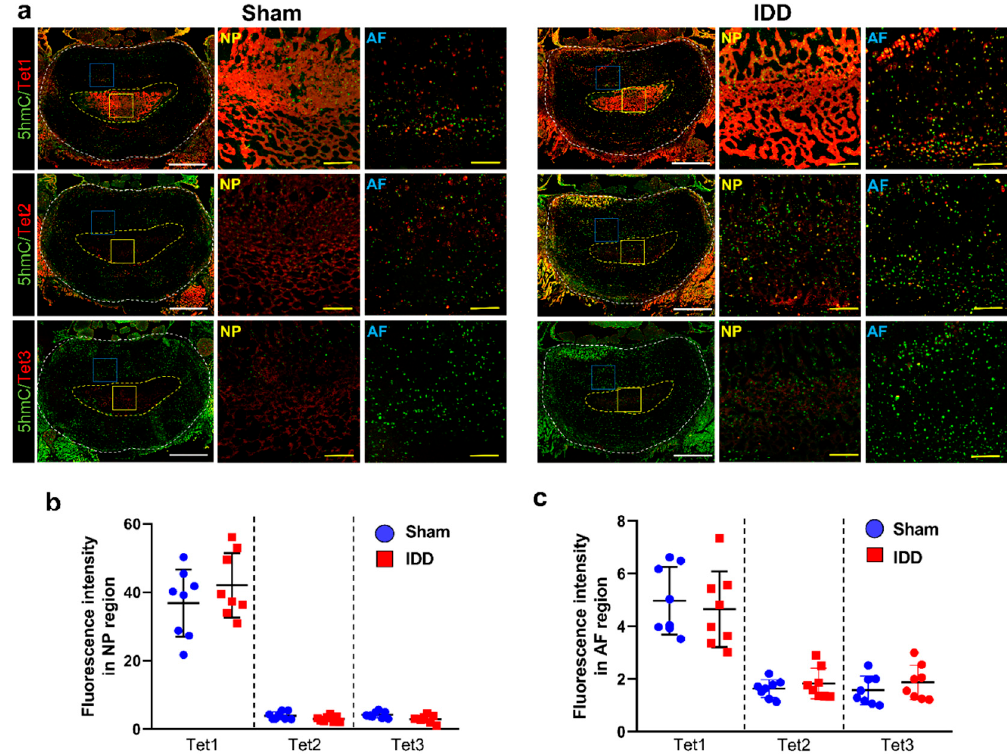
Figure 7. ( a ) Representative immunohistochemical low and high images for 5hmC (green) and Tet1, Tet2, or Tet3 (red) in the NP and AF regions of the sham and IDD groups White scale bar = 1000 µm, Yellow scale bar = 100 µm; ( b , c ) Relative intensity of Tet1, Tet2, or Tet3 expression in the NP and AF regions of the sham and IDD groups ( n = 8/group). Data are expressed as the mean ± SEM. 5hmC, 5-hydroxymethylcytosine; AF, annulus fibrosus; IDD, intervertebral disc degeneration; NP, nucleus pulposus; SEM, standard error of the mean; Tet, Ten-eleven translocation.